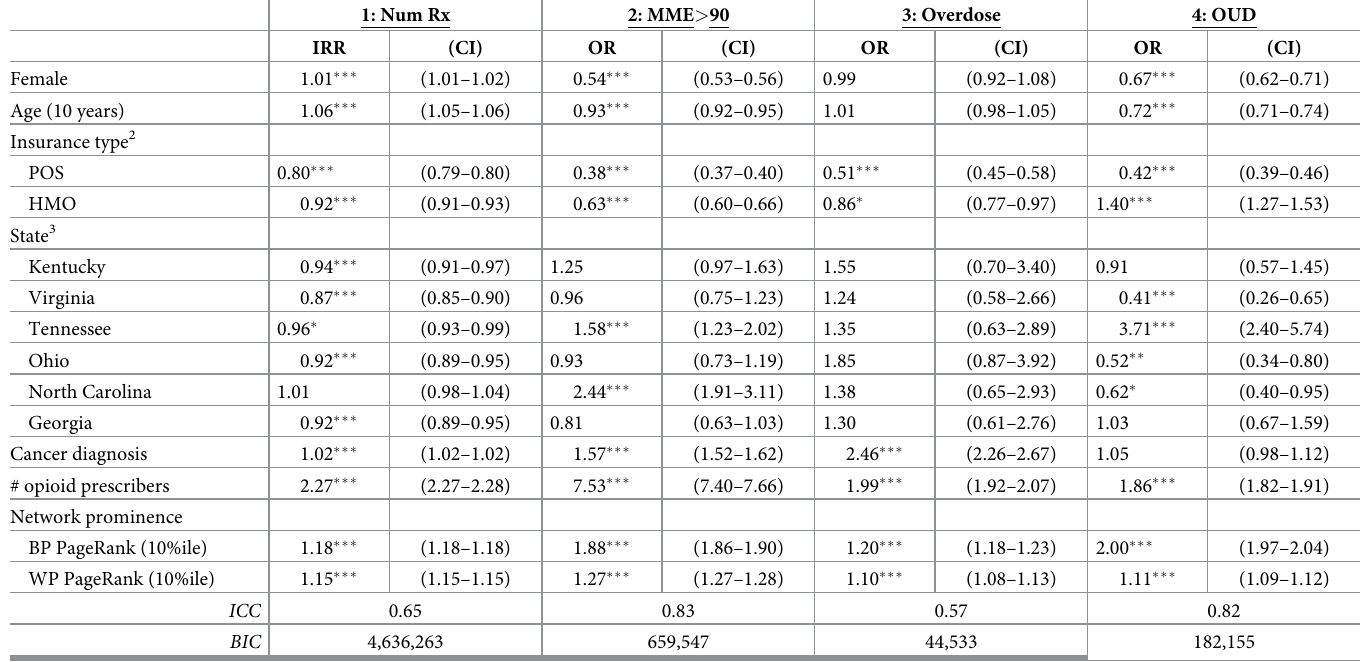
Table 2. Mixed effects regression 1 of opioid outcomes on between-person and within-person patient PageRank percentile and controls (n = 526,914; n obs = 2,107,656)